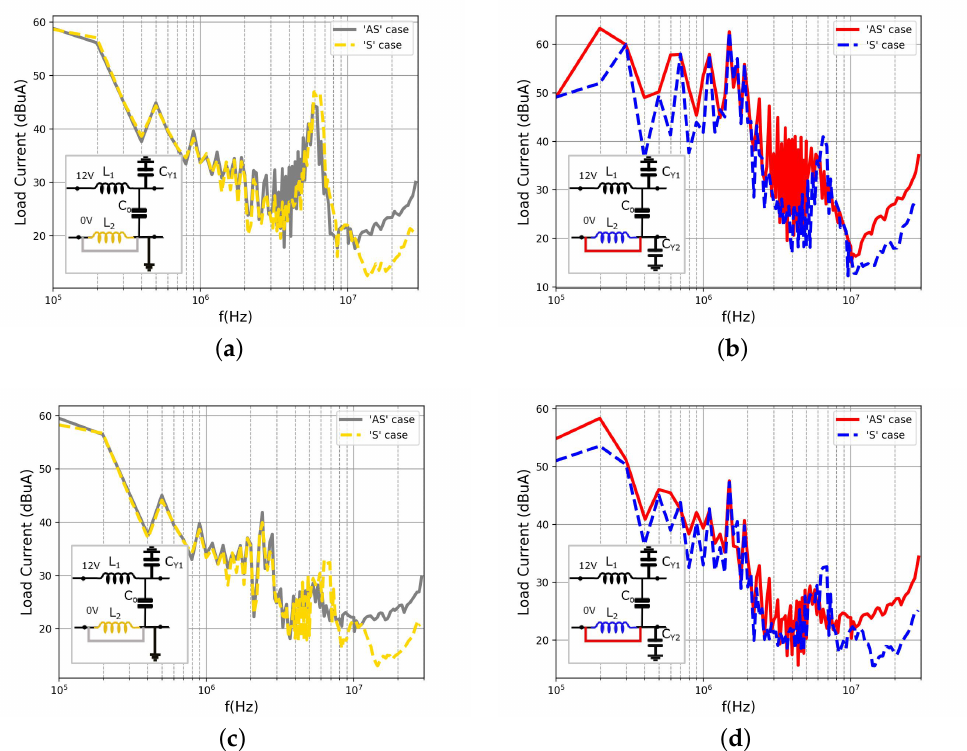
Figure 6. Measured CM output currents for symmetric (‘S’) and asymmetric (‘AS’) cases. ( a ) C y = 10 nF. ‘C0VG’ configuration. ( b ) C y = 10 nF. ‘CC’ configuration. ( c ) C y = 50 nF. ‘C0VG’ configuration. ( d ) C y = 50 nF. ‘CC’ configuration